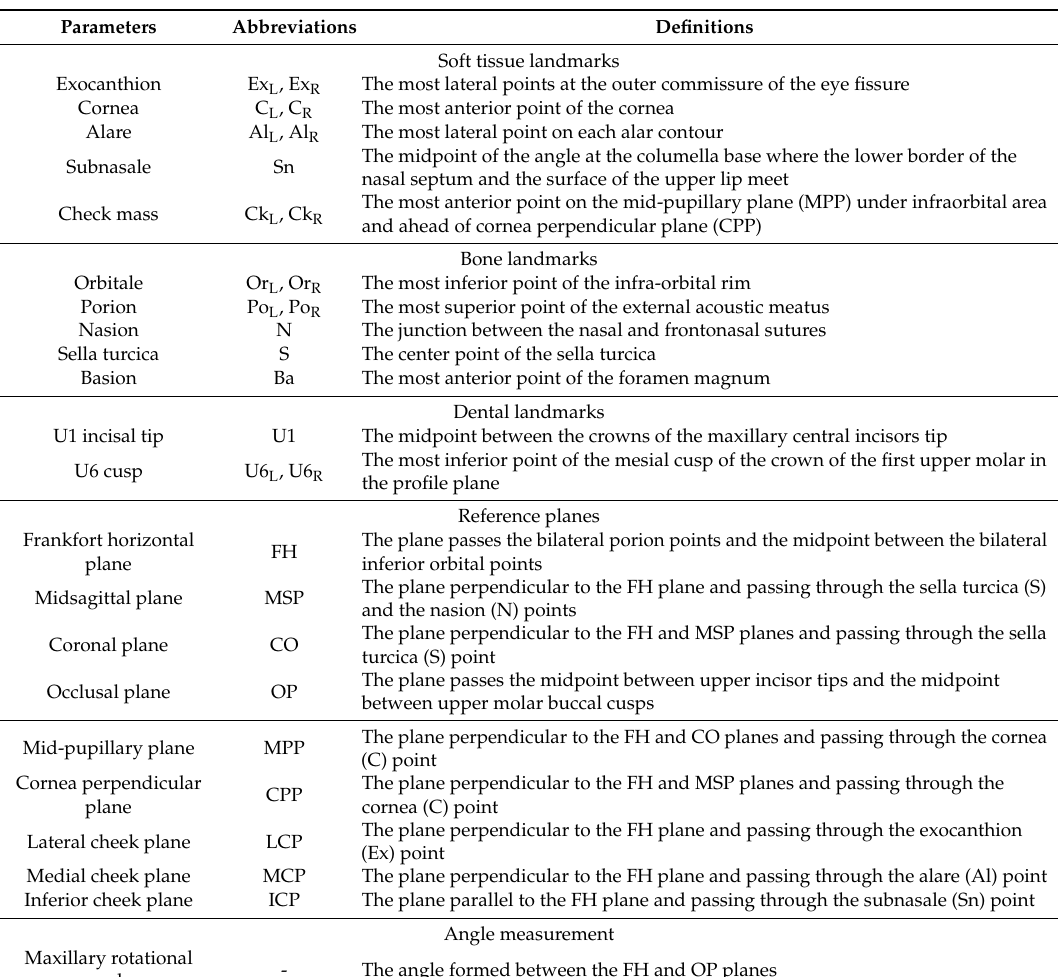
Figure 3. Three-dimensional skeletofacial model displaying the anatomical landmarks and reference planes, including the horizontal plane (X axis; Frankfort horizontal plane, FH), the sagittal plane (Y axis; midsagittal plane, MSP), and the coronal plane (Z axis). For definitions, please refer to Table 2. Table 2. Definition of the three-dimensional anatomical landmarks, reference planes, and measurement parameters.